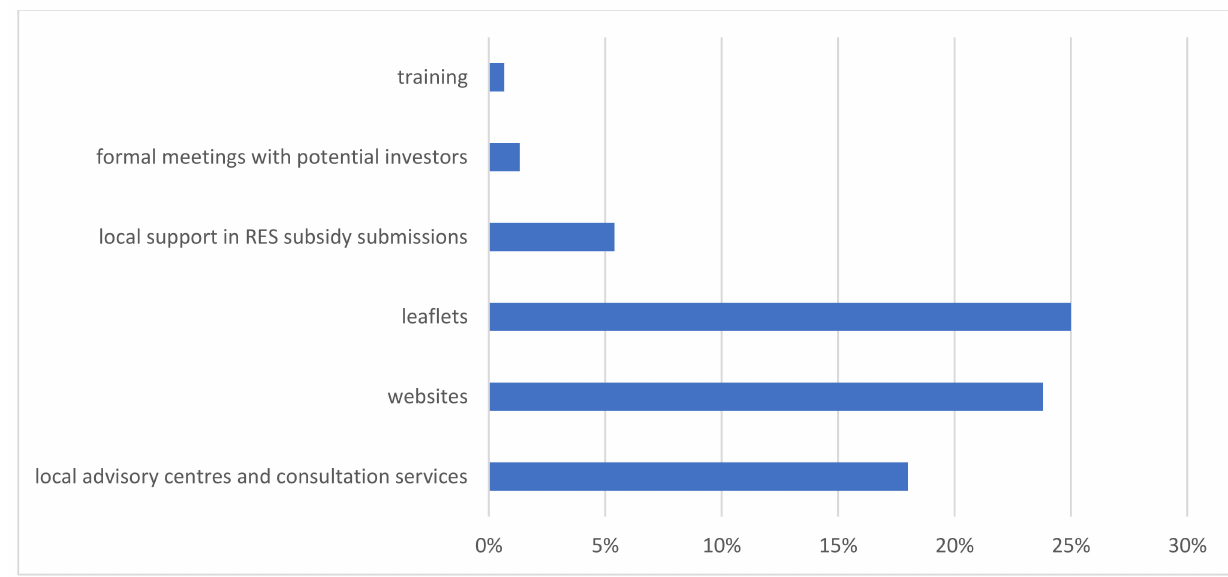
Figure 5. Responses for “Please provide examples of parish/district support for the public in relation to